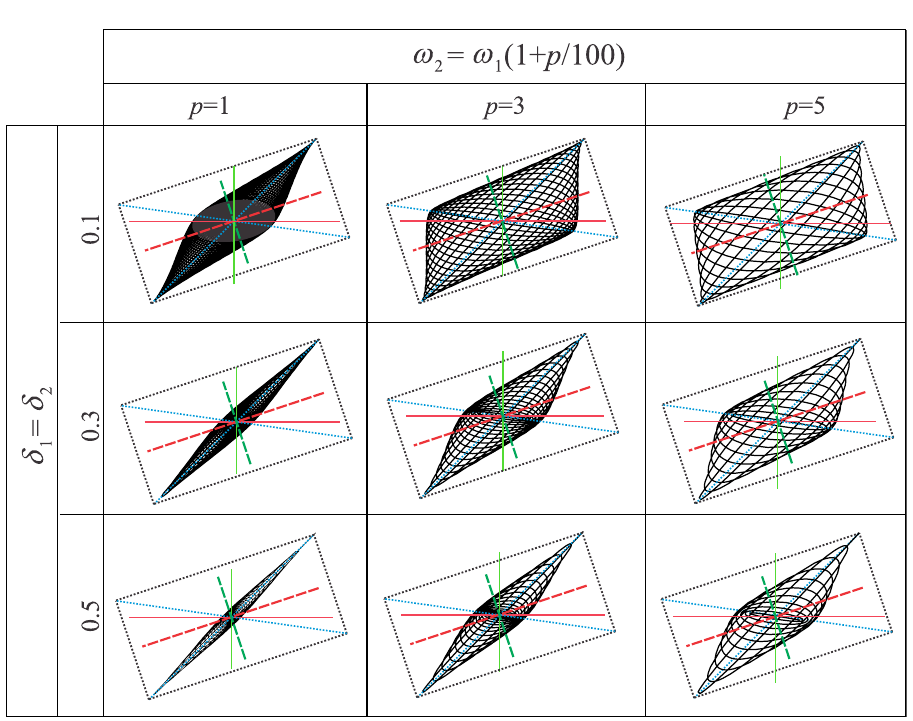
Figure 11. Shapes of trajectories for different percentage differences between the natural frequencies and various values of the damping ratios (note that its units are s − 1 ). The position of the horizontal and vertical (measurement) axes is noted as well as the position of the principal axes and the sides of the rectangle